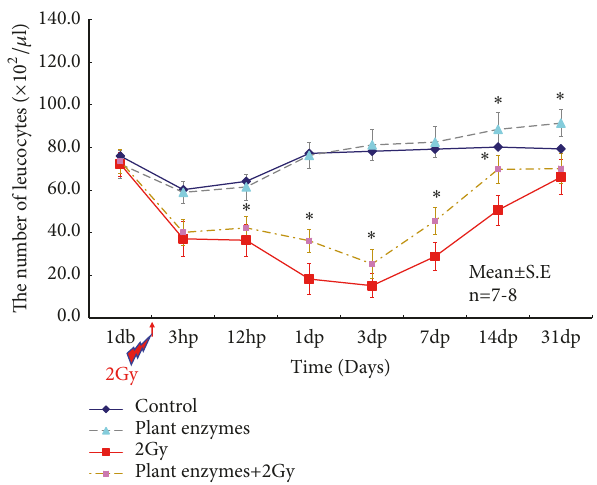
Figure 5: Single-dose effect of Validux Plant Enzyme on blood leukocytecountsinmice.Therewere7-8animalsineachexperimen- tal group. Data are mean ± standard deviation values. Statistically significantly different ( ∗ P < 0.05 ) from the control group. Statisti- cally significantly different ( ∗ P < 0.05 ) from the 2Gy group.